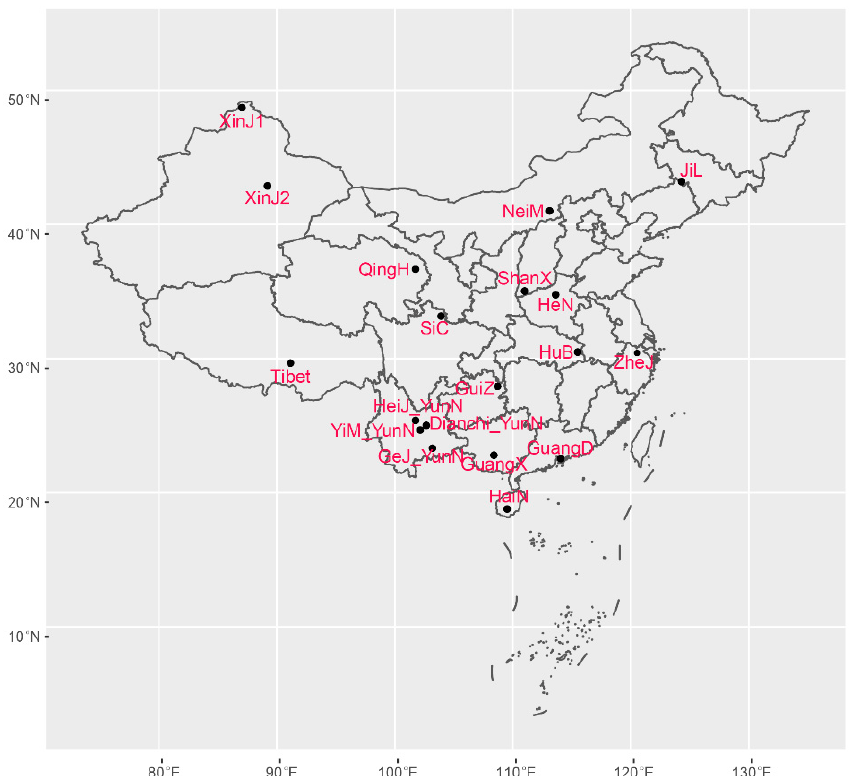
Figure 1. Geographic distribution of all the A. oligospora samples collected in China. Note: the full names of the sampling sites are indicated in Table 1.